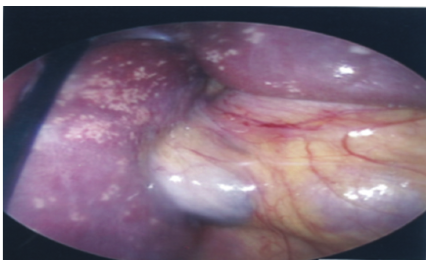
Figure 3: Case 3 demonstrates multiple white raised irregularly shaped lesions on the surface of the liver that were noted at the time of a diagnostic laparoscopy, with biopsies consistent with HSV- 2 hepatitis and confirmed with immunofluorescent staining of the tissue culture